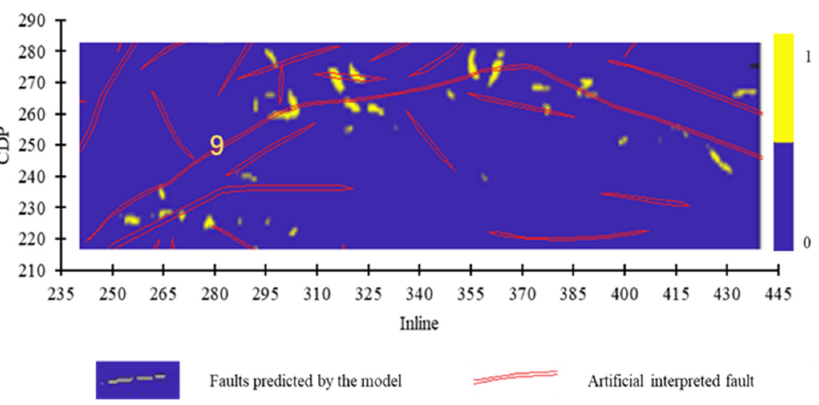
Figure 17. The prediction result of Fault 9 by Region B as a training set.